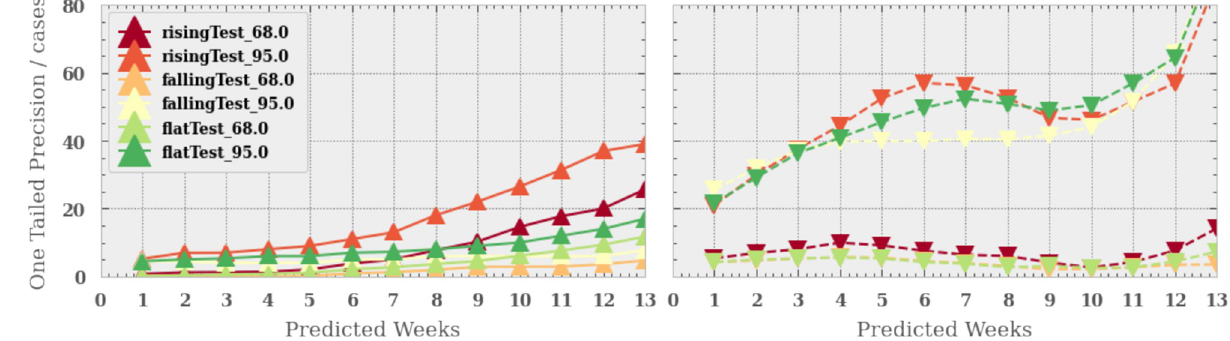
Fig 4. The one-tailed precision for the algorithm as a function of predicted week for the three scenarios and two confidence limits (68% and 95%). The left hand Fig shows the precision for the lower confidence limit and the right hand Fig the precision for the upper confidence limit.